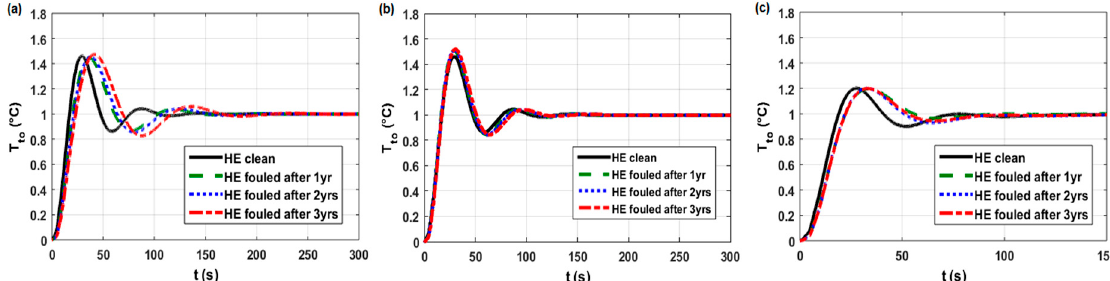
Figure A2. Closed-loop step responses (case in work [6]) under fouling conditions of the HE E15AB models: without adjustment ( a ) after adjustment ( b ) and after adjustment of optimal ( c ) PID tuning parameters.